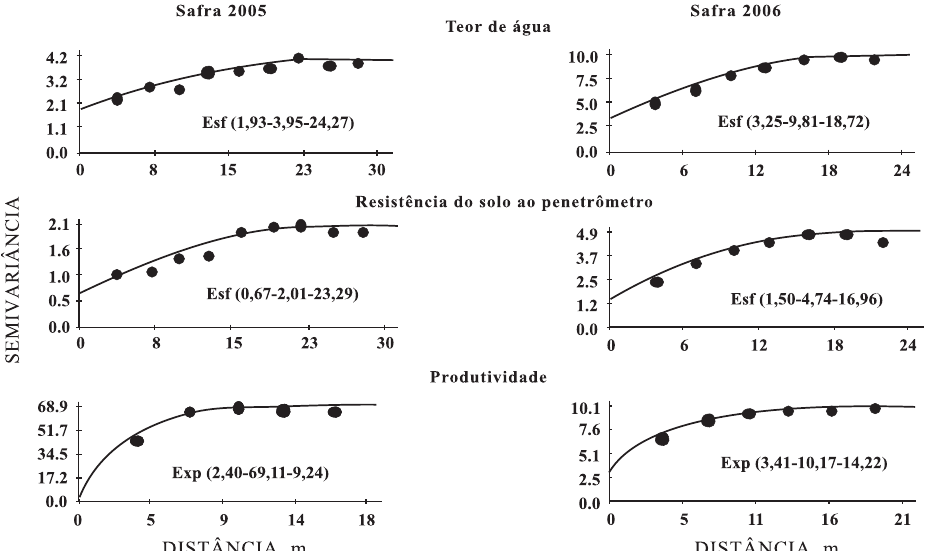
Figura 2. Semivariogramas dos atributos: teor de água no solo, resistência do solo ao penetrômetro e produtividade da cultura do feijoeiro no sistema semeadura direta irrigado para as safras de 2005 e 2006. Esf e Exp (C ; C +C ; a), Esf: modelo esférico; Exp: modelo exponencial; C 0 0 1 patamar; a: